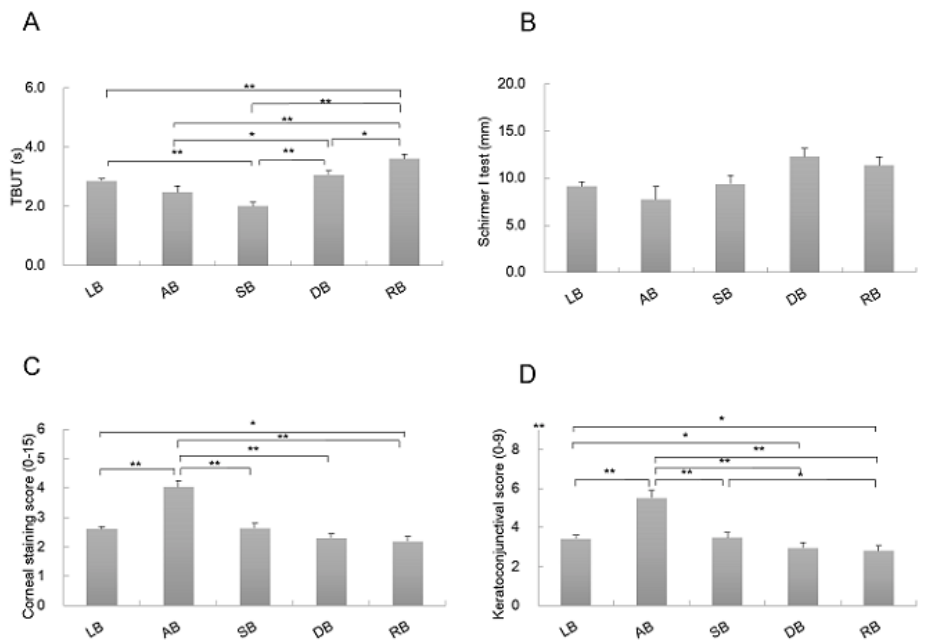
Figure 2. Results of fluorescein breakup patterns of tear examination and ocular surface results. Each graph shows the results of FBUPs of ( A ) FBUT, ( B ) Schirmer I test, ( C ) cornea staining score (National Eye Institute grading system scoring system), and ( D ) keratoconjunctival staining score (van Bijsterveld staining system). AB = area break; DB = dimple break; FBUPs = fluorescein breakup patterns; LB = line break; RB = random break; SB = spot break; FBUT = fluorescein breakup time. Data are estimate ± standard error. * p < 0.05, ** p < 0.01 between two comparisons.